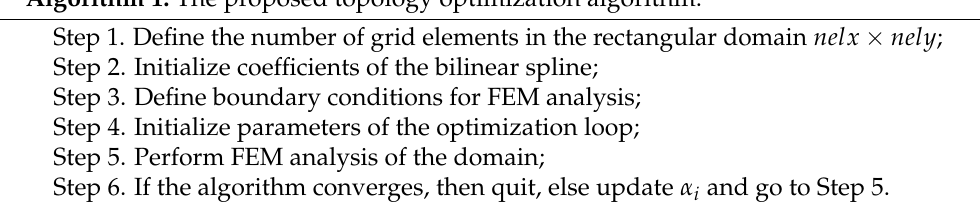
Algorithm 1: The proposed topology optimization